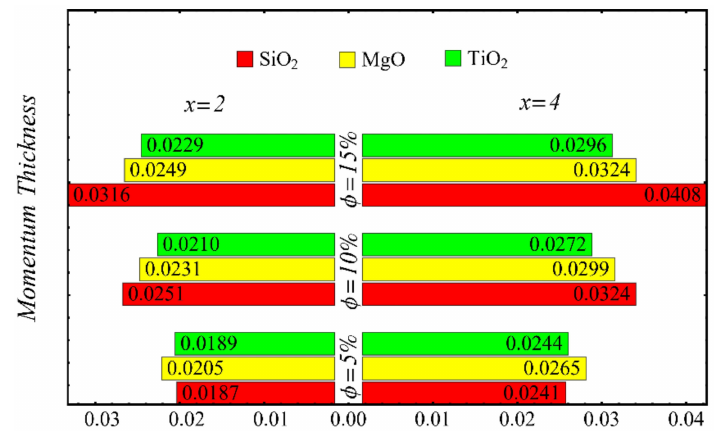
Figure 22. Momentum thickness at different nanoparticle concentrations.